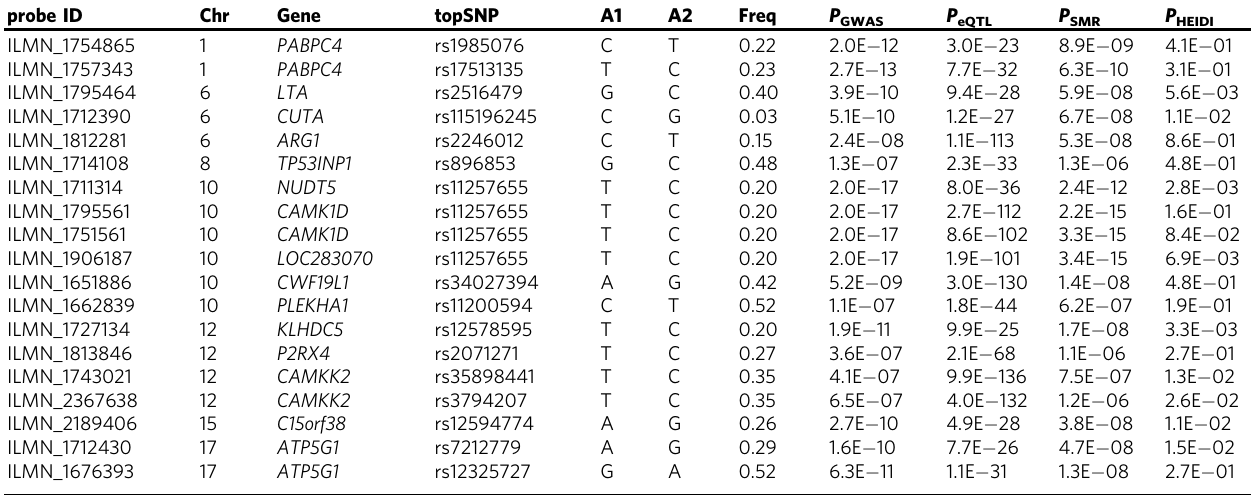
Table 3 Putative functional genes for T2D identi fi ed from the SMR analysis in CAGE probe